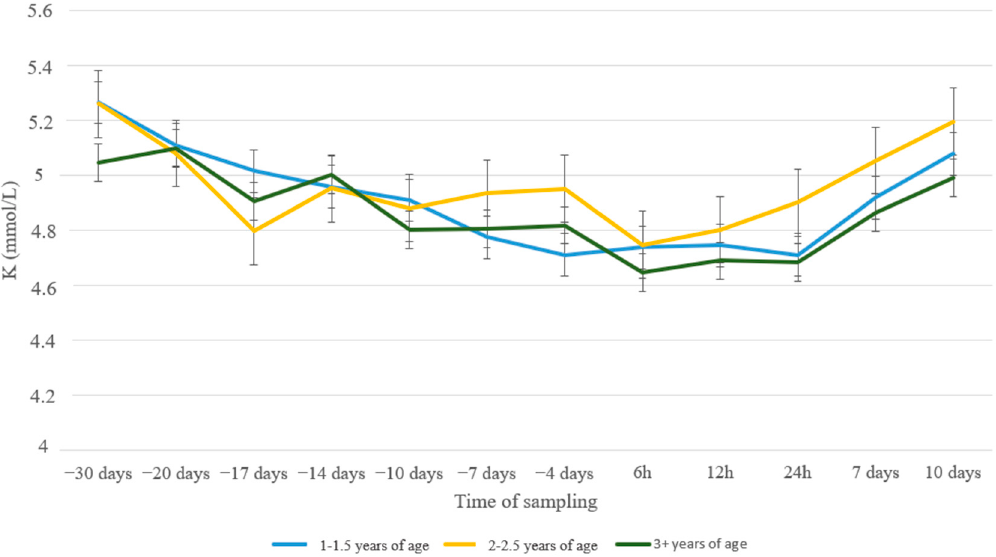
Figure 8. K levels (mmol/L) in blood serum of sheep in age groups 1–1.5 ( n = 35), 2–2.5 ( n = 11) and 3+ ( n = 41) years old during the peri-parturient period.